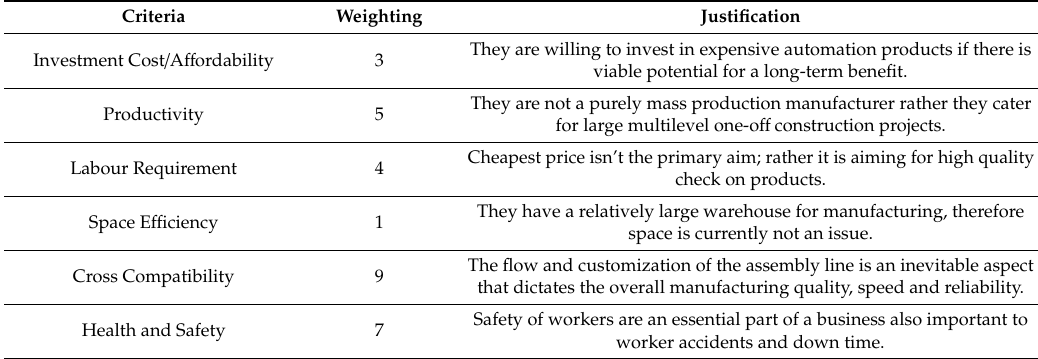
Table 3. Weightings applied in the context of the case study.